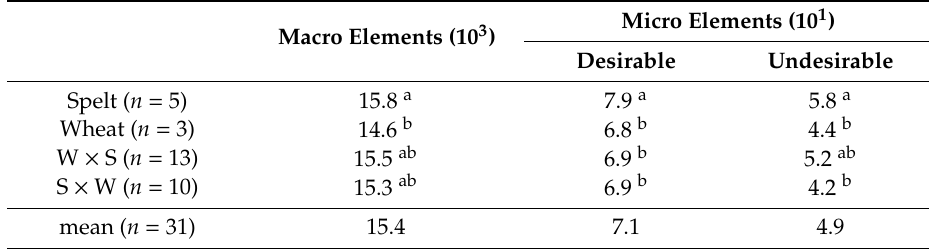
Table 6. The average content (mg kg − 1 ) of macro elements, nutritionally desirable micro elements and undesirable micro elements in the grain of the studied cereals in the two-year